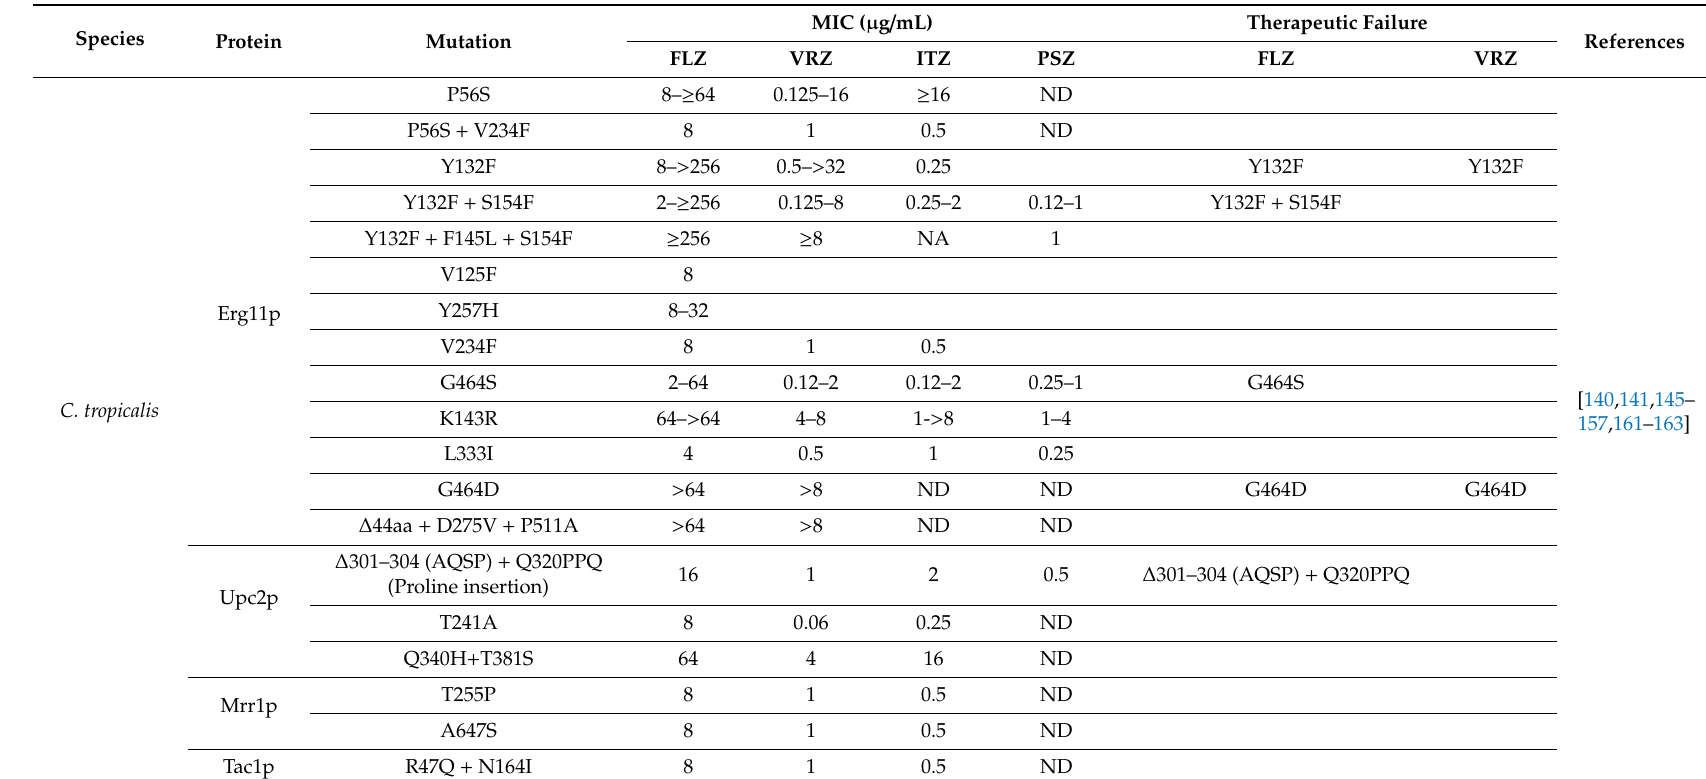
Table 2. Mutations involved in azole resistance and their in vitro and in vivo